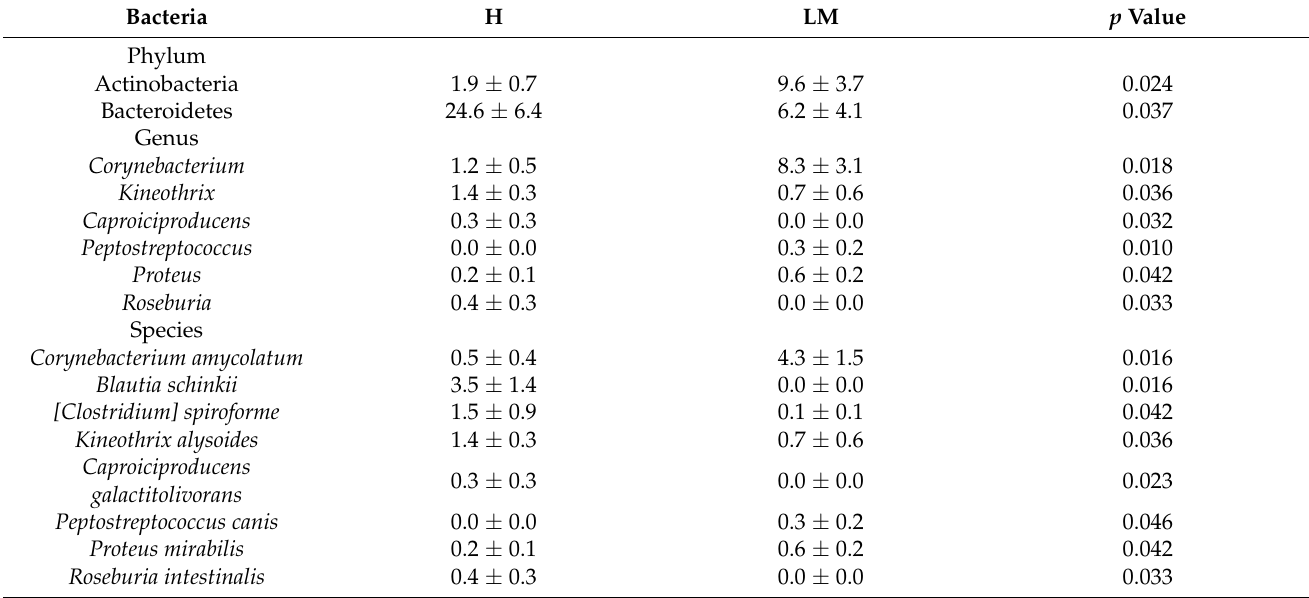
Table 3. Relative abundances of main bacterial groups (more than 0.1% proportion) in healthy (H) and lymphoma (LM) dogs at the phylum, genus, and species